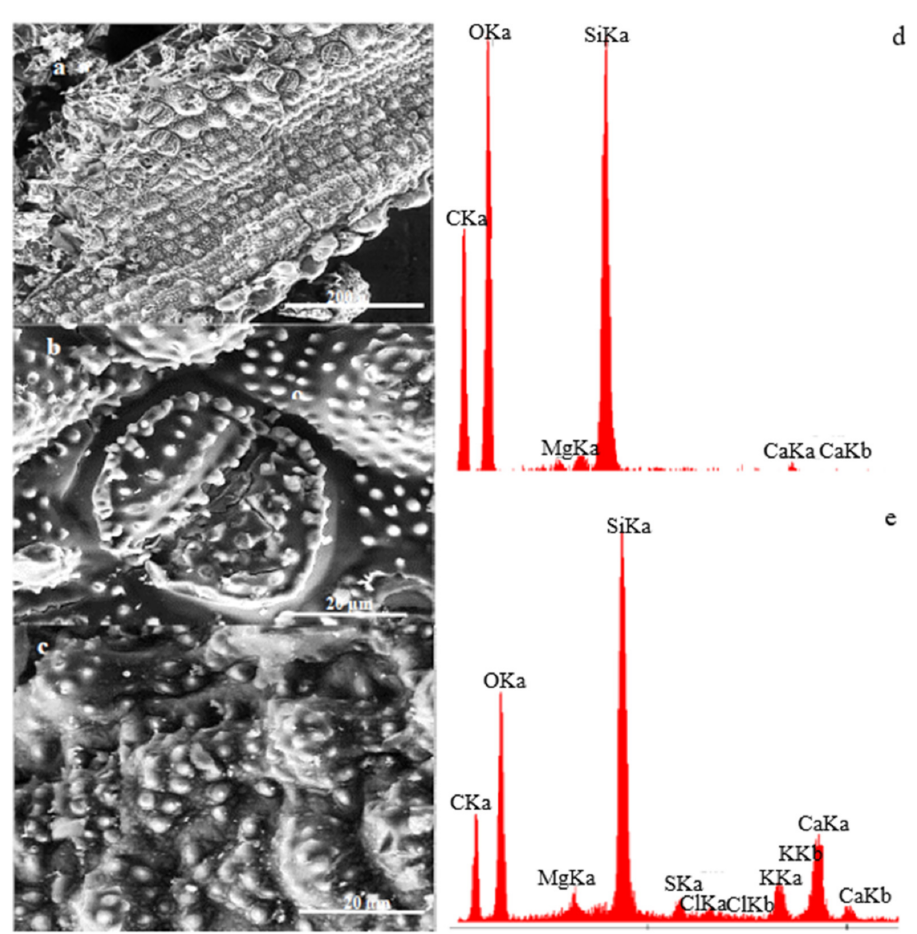
Figure 10. Horsetail–SEM ( a )—350 × , ( b )—3000 × , ( c ) horsetail after carbonization—3000 × , ( d ) horse- tail EDS before carbonization, ( e ) horsetail EDS after